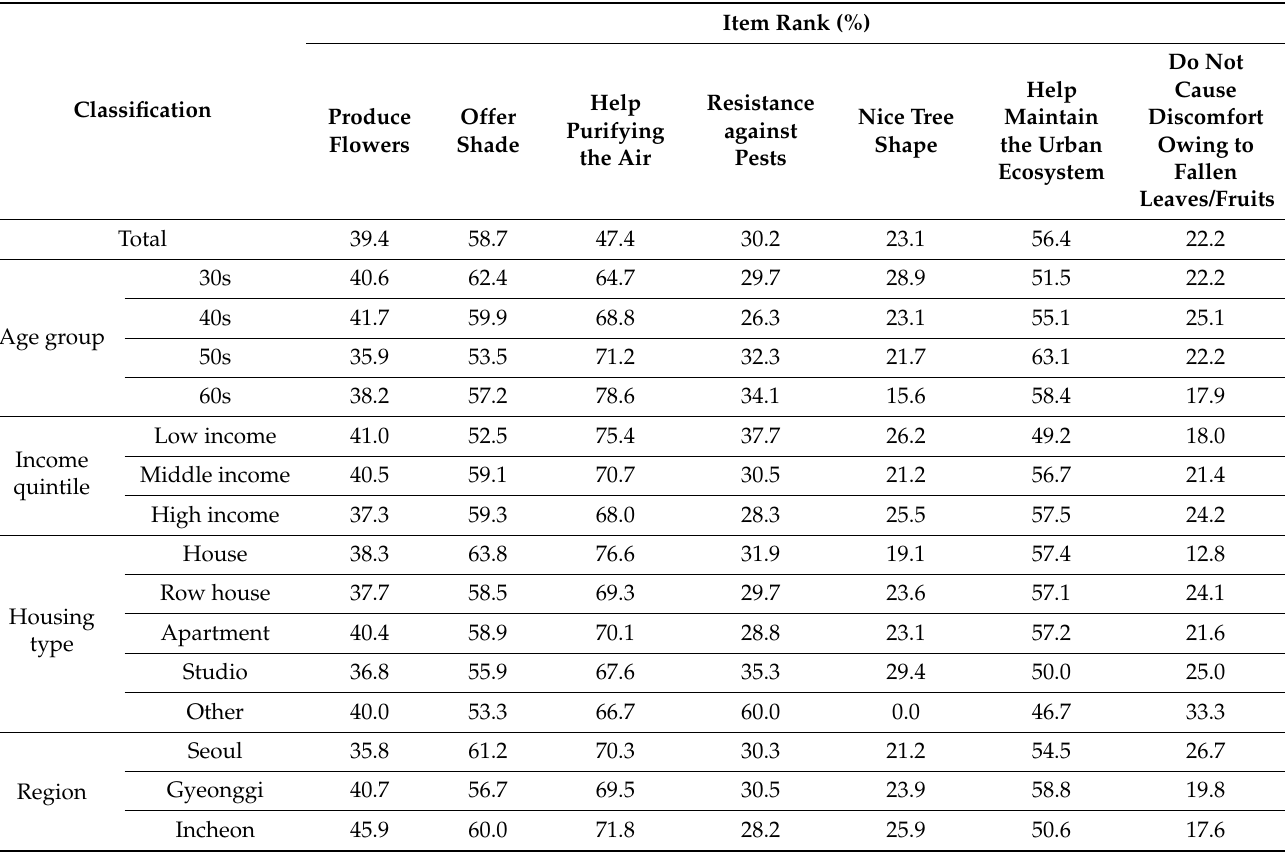
Table 5. Demographic characteristics of item rankings for preferred street tree